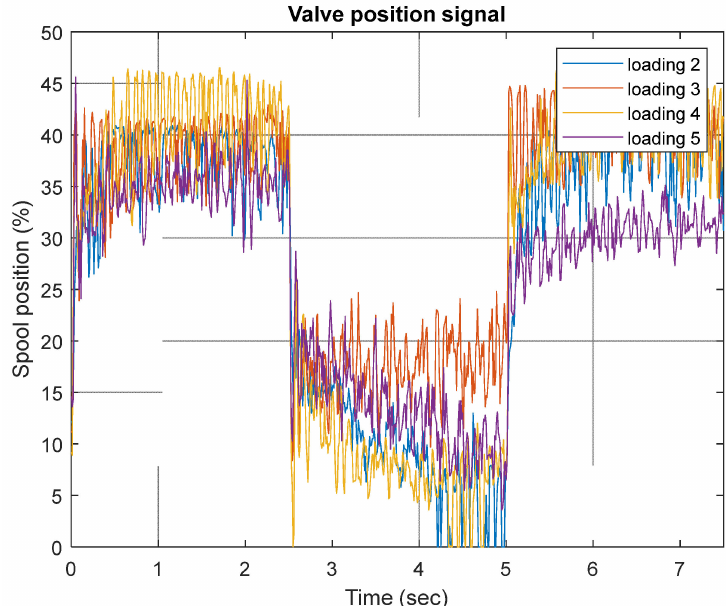
Figure 19. Measured proportional valve position.